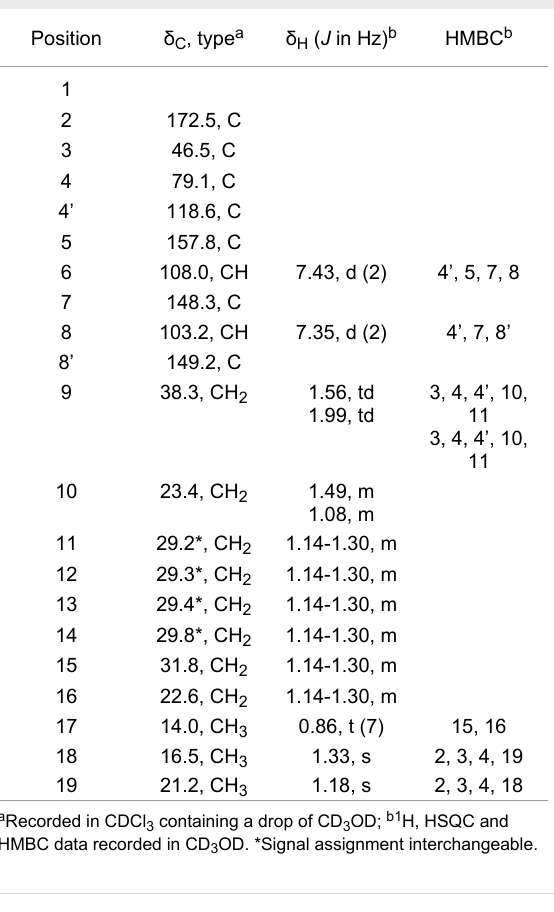
Table 1: NMR data of compound 7 at 500 ( 1 H) and 150 ( 13 C)